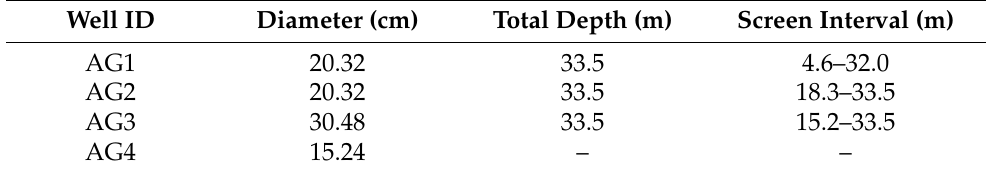
Table 1. Well construction data for irrigation wells used in this study. Screened intervals are measured from the top of steel casing. The dash (–) indicates that data are not available.